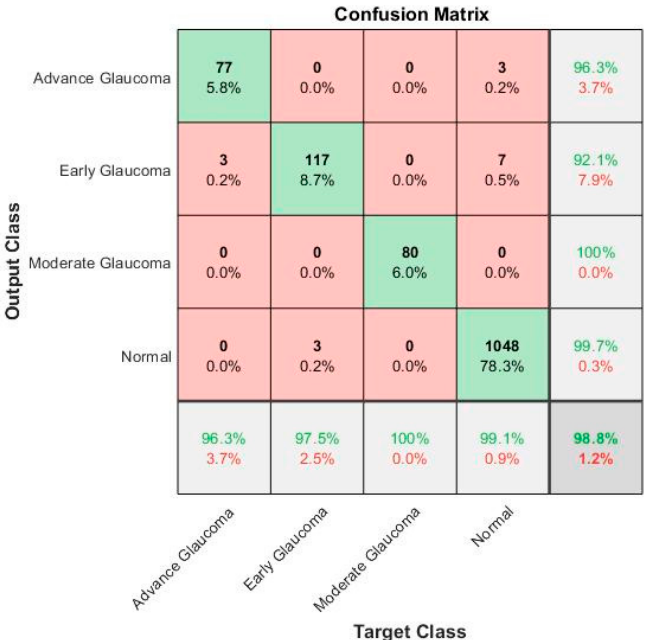
Figure 9. Confusion matrix of the 4-class glaucoma classification using the proposed ML-DCNN Model on the Local Retinal Glaucoma Image Dataset.